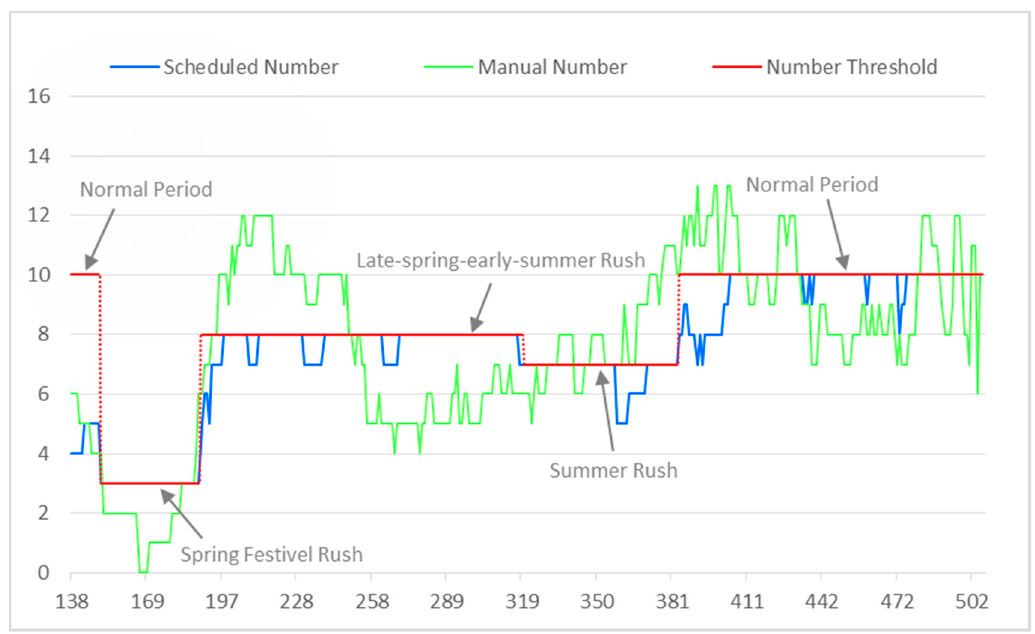
Figure 6. The number of train-sets be maintained for different periods within the year of 2017.